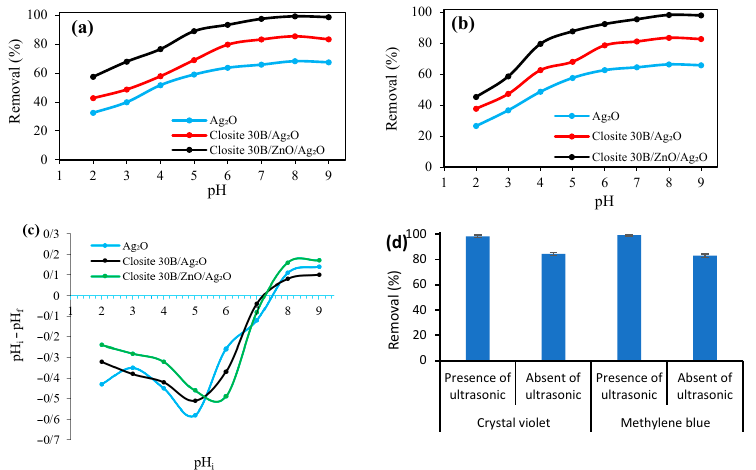
Figure 6. The pH effect on the removal efficiency of ( a ) crystal violet and ( b ) methylene blue using Ag 2 O, Cloisite 30B/Ag 2 O and Cloisite 30B/ZnO/Ag 2 O (dyes concentration: 5 mg/L, reaction time: 50 min, catalyst dosage: 0.5 g/L, amount of H 2 O 2 : 40 µL/100 mL) and ( c ) pH i -pH f versus pH i to deter- mine pH zpc , ( d ) the efficiency of dye removal in the presence and absence of ultrasonic waves.